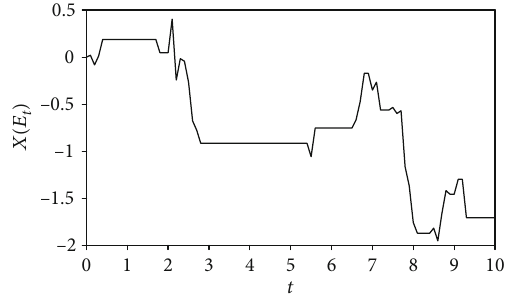
Figure 3: The sample paths of the stochastic process X ð E α = 0 : 9 , α = 0 : 5 , v = 0 : 05 , and D = 0 : 5 . 1 2